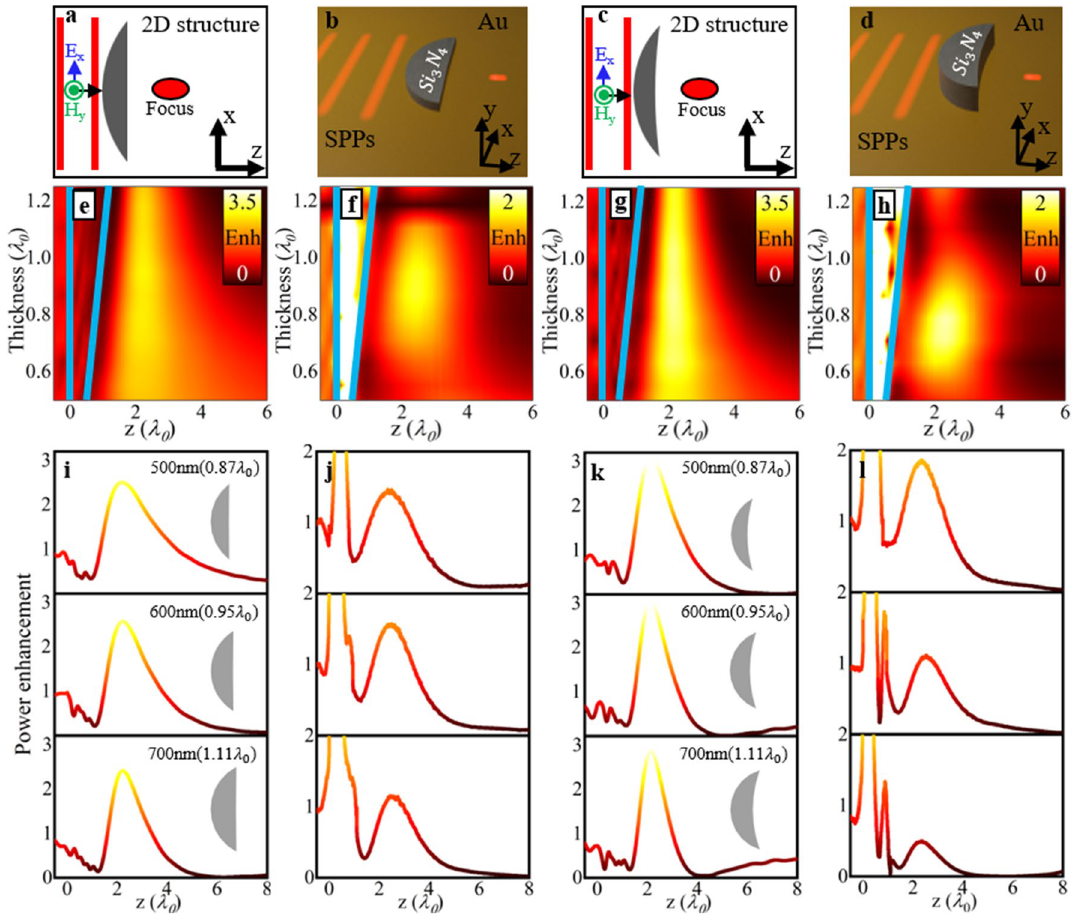
Figure 2. Schematic representations of the convex-planar ( a, b ) and the positive meniscus ( c , d ) lenses considered as a 2D structure illuminated with a vertically polarized plane waves ( a , c ) and 3D plasmonic configuration for SPP focusing ( b , d ). ( e – h ) Power enhancement on the surface of the metal ( y = 0) at the centre of the lens ( x = 0) for convex-planar lens ( e ) in 2D and ( f ) 3D plasmonic configurations and positive meniscus lens ( g ) in 2D and ( h ) 3D plasmonic configurations for a range of thicknesses, t . Note that the results shown in ( g ) has been saturated using the same scale as ( e ) to best show the improved power enhancement. Also, note the aspect ratio for the x- and y -scales in ( e )–( h ) are not spatially matched to better appreciate the response of the lenses when changing their thickness. ( i – l ) Power enhancement on the surface of the metal ( y = 0) at the centre of the lens ( x = 0) at specific thicknesses (0.87 λ 0 , 0.95 λ 0 and 1.11 λ 0 ) when the lens is modelled as a convex-planar lens ( i ) in 2D and ( j ) 3D plasmonic configurations and positive meniscus lens ( k ) in 2D and ( l ) 3D